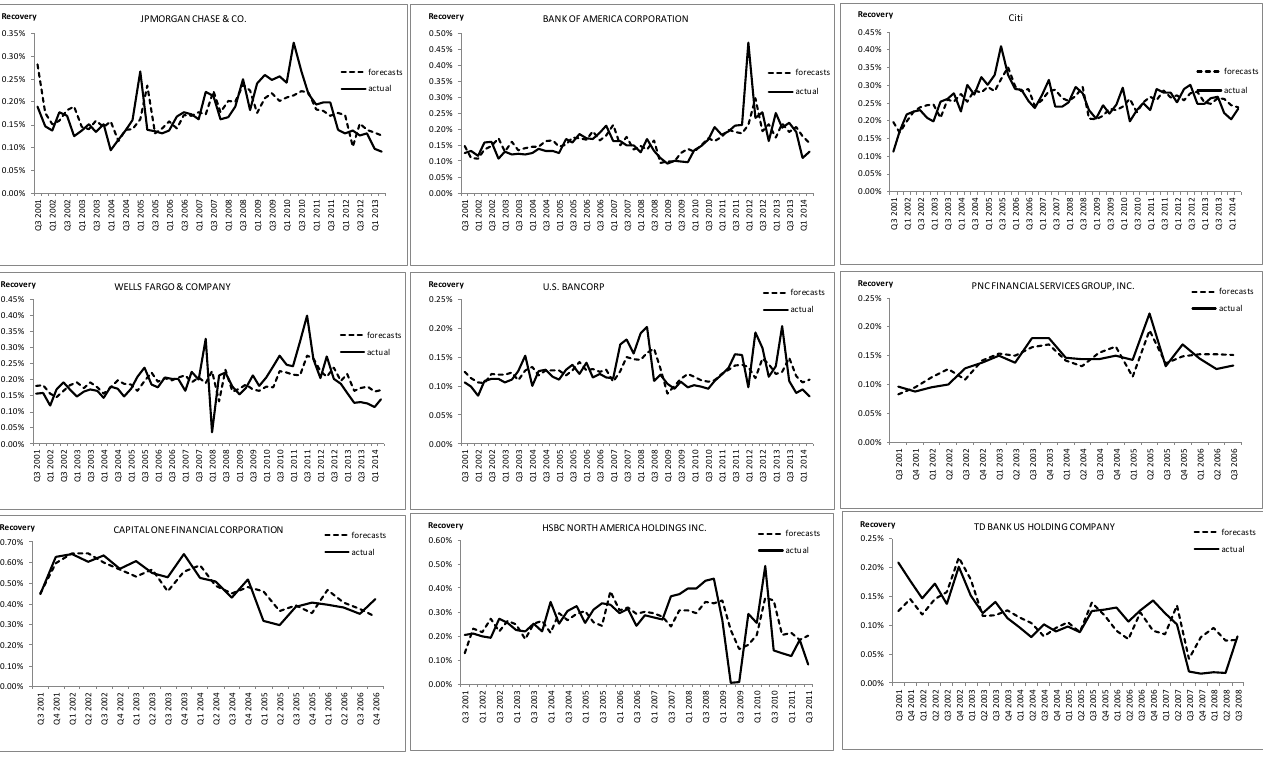
Figure 6. Recovery rates—regression forecasts vs. actual values. Source: Author’s work. Table 2 contains regression outcomes including R-squared, adjusted R-squared and p -values calculated for F statistic. The table’s right panel presents macro factors that appeared to be significant and were selected as regressors. Numbers below the variable names indicate the lag, which was employed for a particular macro factor. Table 2. Regression results.